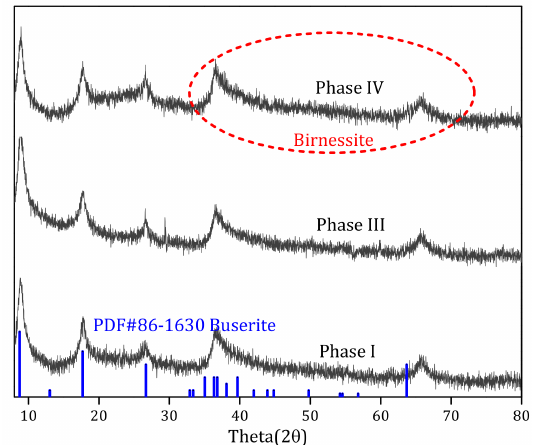
Figure 9. X-ray di ff raction (XRD) analysis of the Fe–Mn co-oxide filter media at di ff erent operational